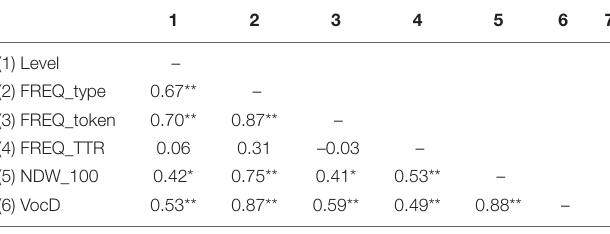
TABLE 2 | Correlations between vocabulary indices and grade level.